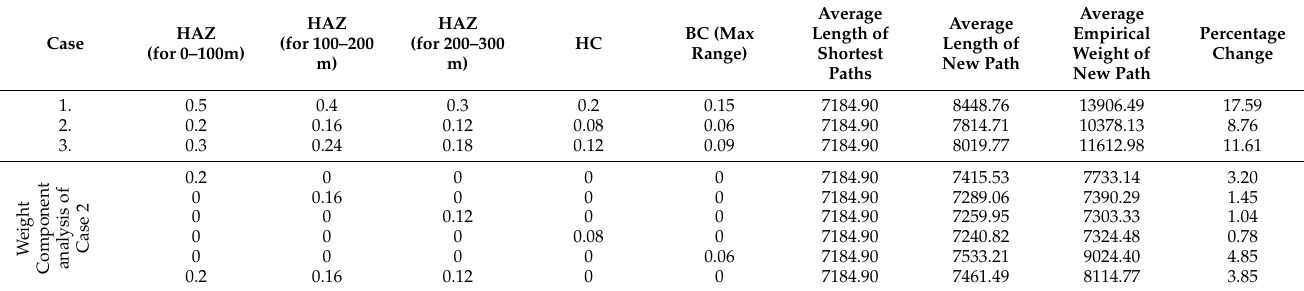
Table 1. Cost function hyper parameters analysis for 1000 different path